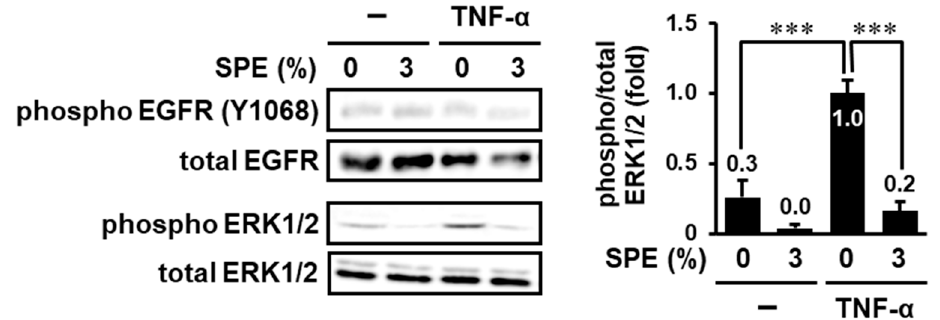
Figure 3. SPE suppresses EGFR-independent activation of ERK1/2 by tumor necrosis factor (TNF)- α . HaCaT cells were serum-starved for 2 h and were treated with 3% SPE for 1 h. Then, the cells were stimulated with 10 ng/mL TNF- α for 1 h. The cell lysates were analyzed by immunoblot analysis. The levels of phosphorylated proteins were normalized to those of total proteins. The data are expressed as the mean ± SE derived from at least three independent experiments, and statistical analysis was performed by ANOVA with Bonferroni’s multiple comparisons test; *** p < 0.001.